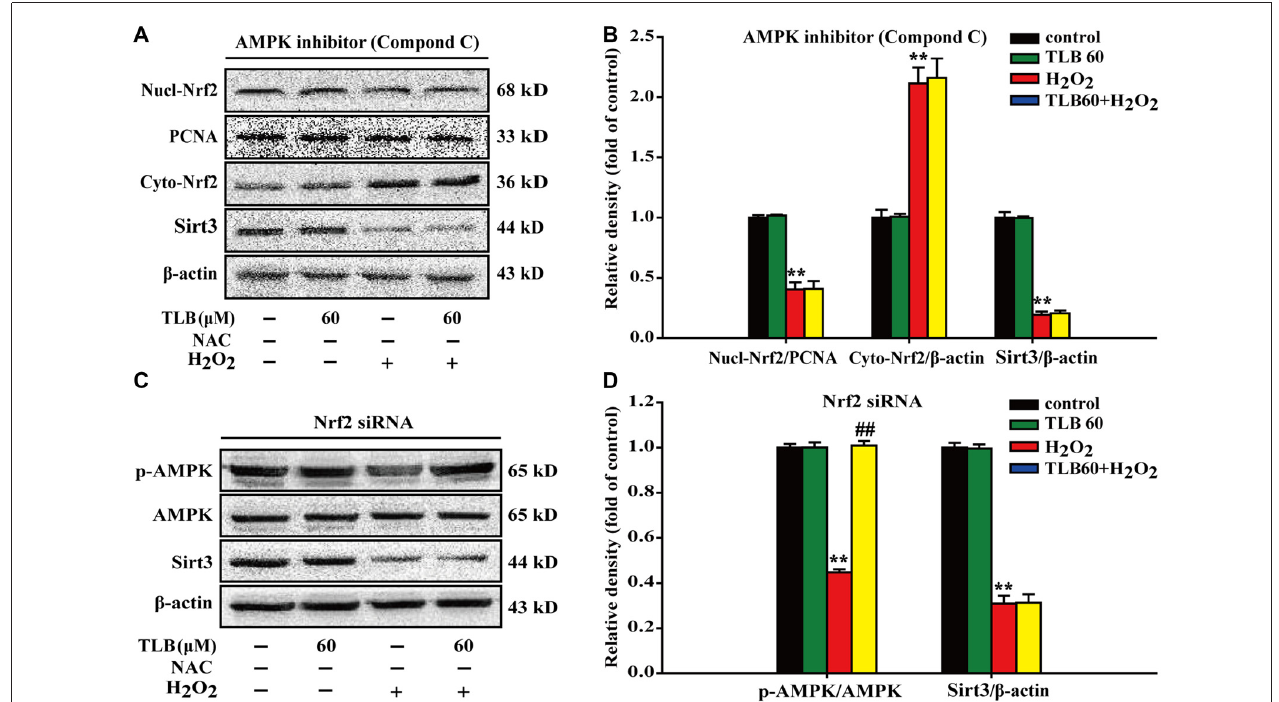
FIGURE 7 | The role of AMPK/Nrf2/Sirt3 axis in the protective effect of TLB on H 2 O 2 -induced PC12 cells injury. AMPK inhibitor was added to the cell cultures 1 h or Nrf2 was knocked down by Nrf2 siRNA transfection as mentioned in the “Materials and Methods” section. Following pre-treatment with or without TLB for 1 h and incubated with 400 µ M H 2 O 2 for further 48 h. (A) Representative Western blot were shown for Nucl-Nrf2, Cyto-Nrf2 and Sirt3 proteins. (B) Quantitation of Nucl-Nrf2, Cyto-Nrf2 and Sirt3 proteins. (C) Representative Western blots were shown for p-AMPK and Sirt3 proteins. (D) Quantitation of p-AMPK/AMPK and Sirt3. Data were presented as mean ± SD of three independent experiments. ∗∗ P < 0.01 vs. untreated control cells; ## P < 0.01 vs. H 2 O 2 -treated